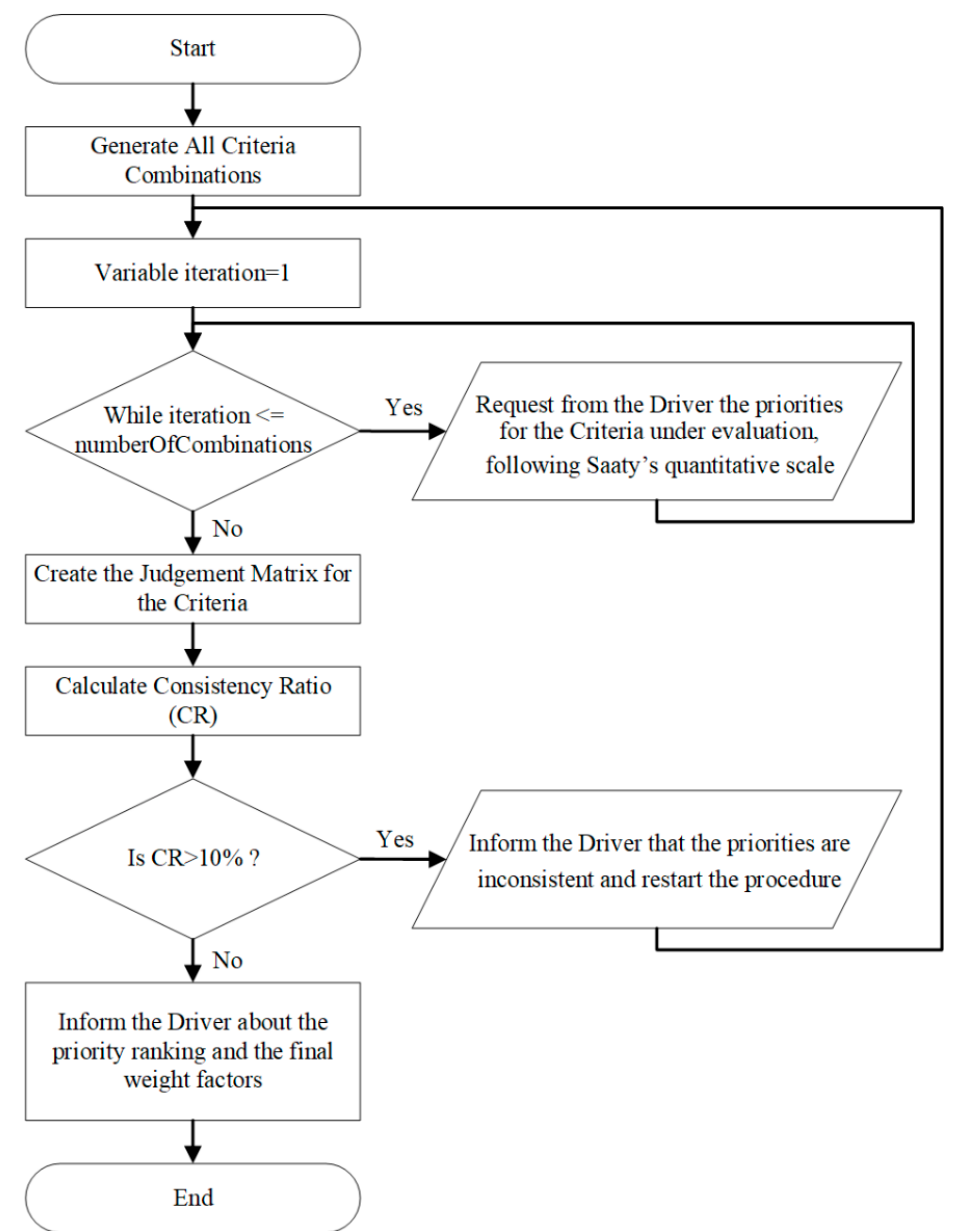
Figure 4. The flowchart for the quantification of the driver’s priorities.